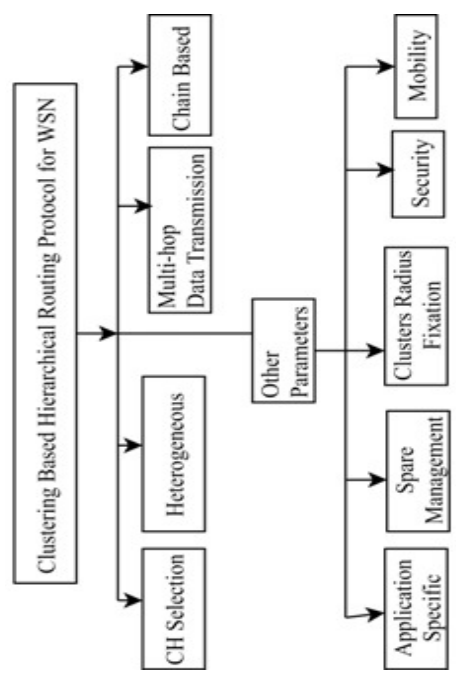
Figure 4. Numerous techniques related to routing protocol of